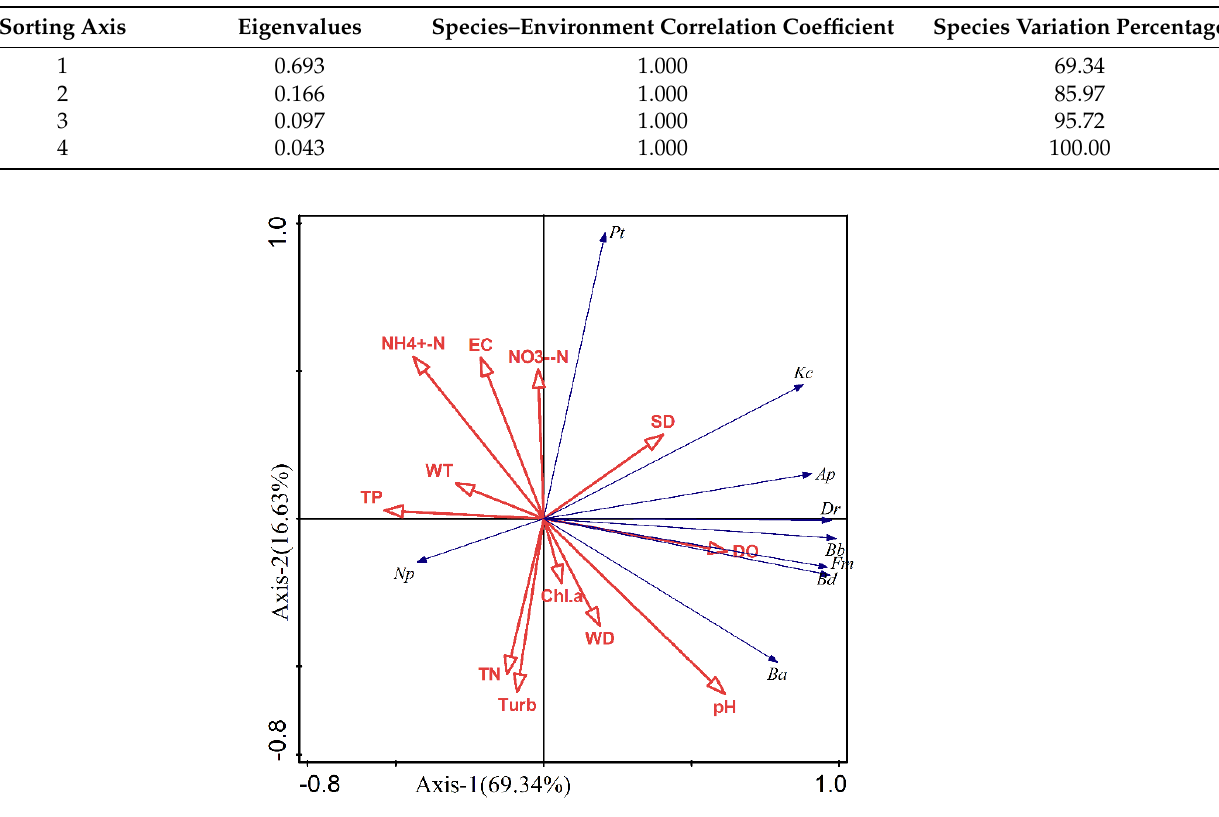
Figure 11. RDA analysis ranking the biomass of dominant species of zooplankton and environmental factors in the surrounding area of Lake Chen Yao and Lake Feng Sha. ( Bb: Brachionus budapestinensis ; Kc : Keratella cochlearis ; Dr : Diurella rousseoeti ; Ap : Asplanchna priodonta ; Pt : Polyarthra trigla ; Fm: Filinia maior ; Ba : Brachionus angularis ; Np : Nauplius ; Bd— Brachionus diversicornis ).